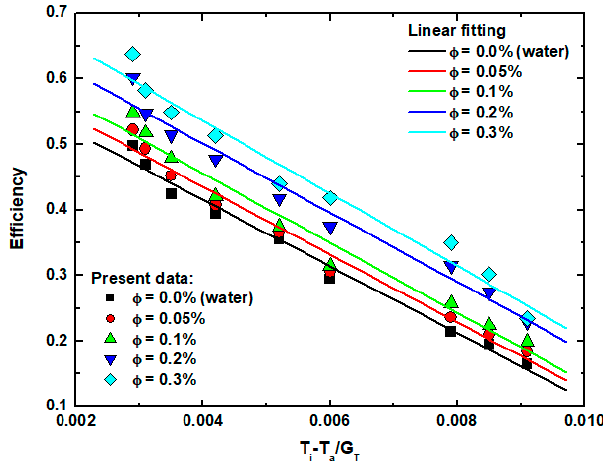
Figure 17. Variation of collector efficiency using water and hybrid nanofluids against daytime.